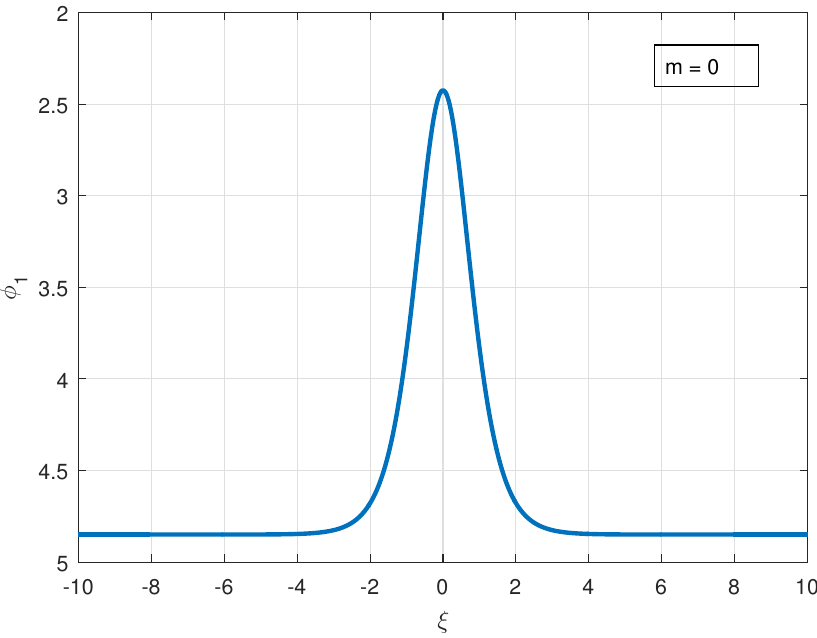
Figure 10. The quasi-soliton transforms to pure soliton for m → 0. Moreover, in the Figure 11 we show the three dimensional form of this new wave form. Lastly, in Figure 12, we show a contour plot of φ 1 where the ordinate is time ‘ τ ’ and the abscissa is ‘ ξ ’ for different parameter values.